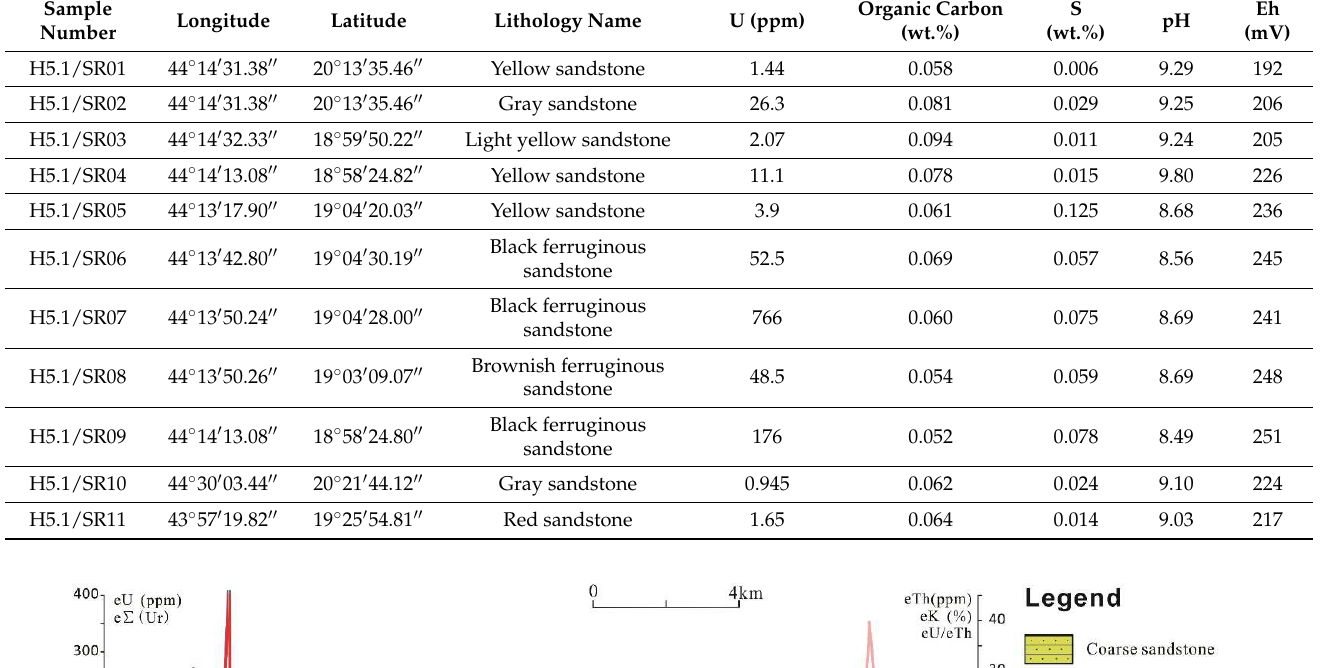
Table 2. pH and Eh values of sandstone in the Khusayyayn Formation in study area.